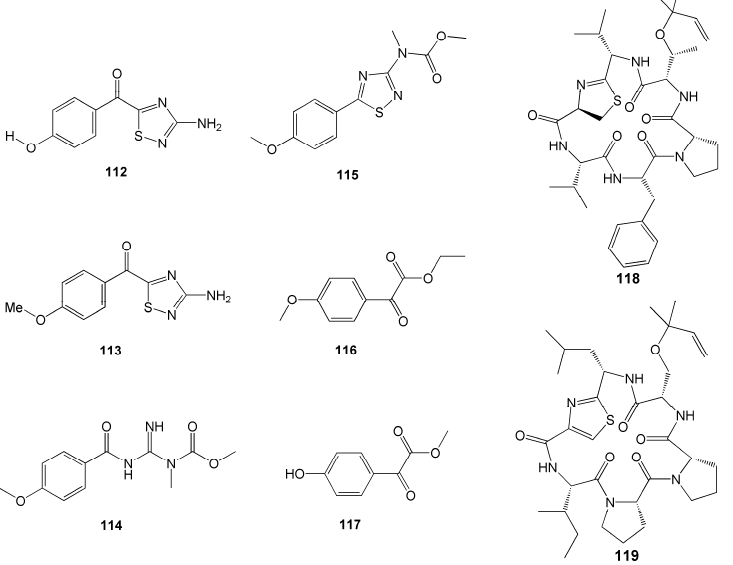
Figure 11. Chemical structures of 112 – 119. Two new cyclic hexapeptides, mollamides B ( 118 ) and C ( 119 ) (Figure 11), were isolated from D. mole found in Manado Bay, Indonesia. Compound 118 was found to have an antiparasitic activity against Plasmodium falciparum D6 clone (IC 50 = 2.9 µ M), P. falciparum W2 clone (IC50 = 3 µ M), and Leishmania donovani (IC 50 = 25.9 µ M and IC 90 = 50.3 µ M) [54]. Compound 118 also displayed antiviral activity against HIV-1 in human PBM cells with an EC 50 value of 48.7 µ M and anticancer activity against the non-small lung H460, the breast MCF-7, and the human glioblastoma CNS SF268 cancer cell lines [54]. Furthermore, compound 119 showed anticancer activity with a unit zone differential value of 100 against mouse lymphocytic leukaemia L1210, human colon HCT116, and human lung H125 cells. This compound also showed a differential value of 250 against murine colon 38 [54]. However, compounds 118 and 119 did not show anti-inflammatory activity either in vitro in a cell-based assay through a cyclooxygenase enzyme (COX-2) activity assay or in vivo in rat neonatal microglia [54]. Furthermore, compounds 118 and 119 did not show antimicrobial activity against MRSA, Mycobacterium intracellulaire, Candida albicans, C. glabrata, C. krusei , nor Cryptococcus neoformans